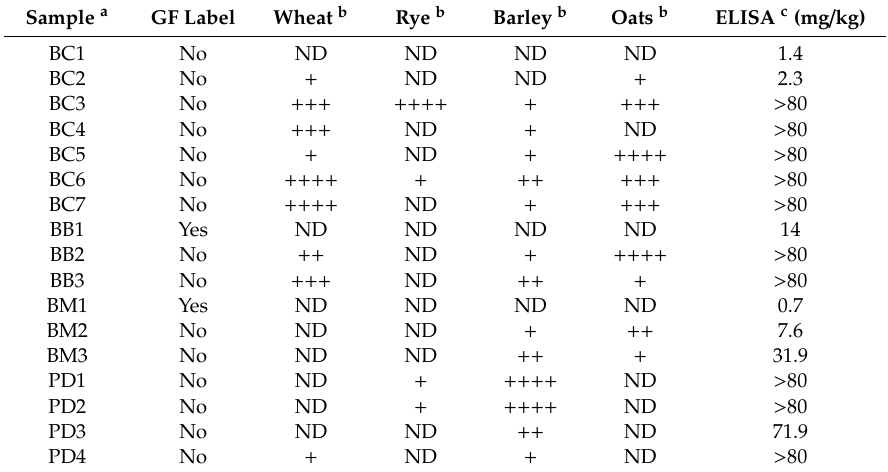
Table 1. ELISA measurement of commercial food